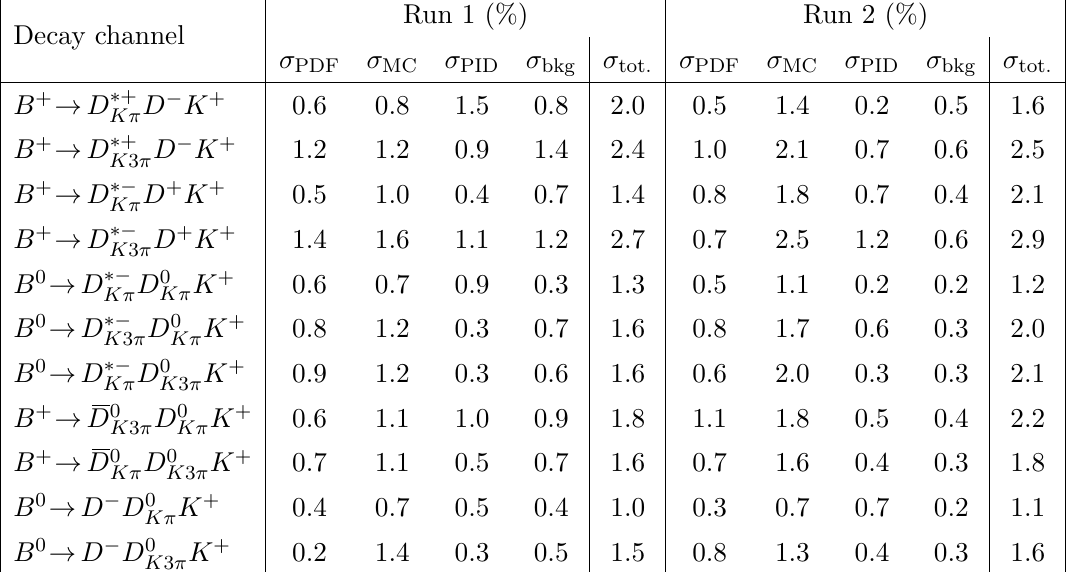
Table 3 . Systematic uncertainties on N corr from the signal PDF parameters ( σ PDF ), the finite simulation samples ( σ MC ), the PID resampling ( σ PID ), the residual peaking background ( σ bkg ), and the total systematic uncertainty ( σ tot . ). All values are given as a percentage of the central value of N corr